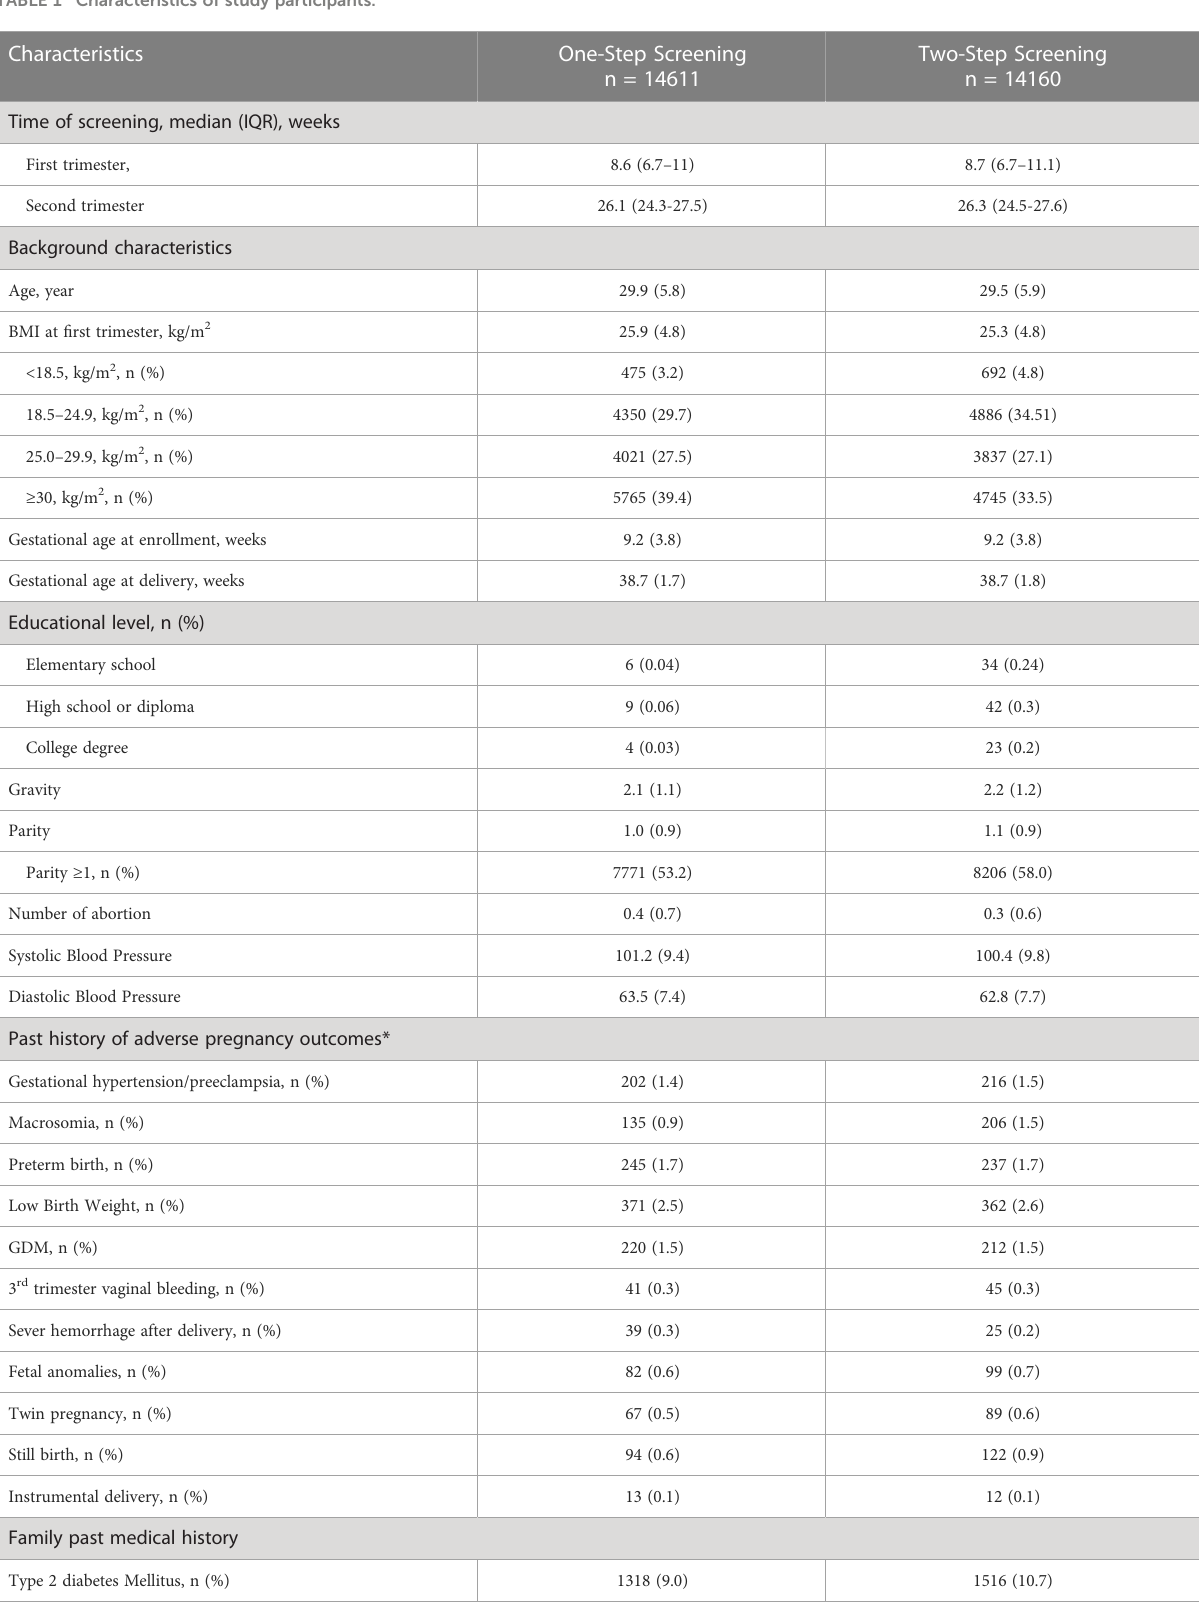
TABLE 1 Characteristics of study